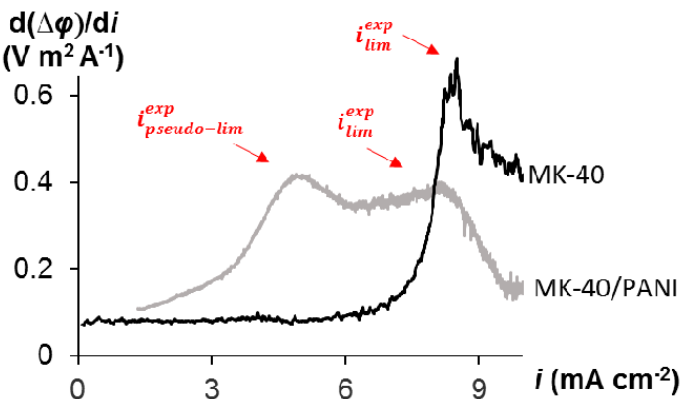
Figure 3. Derived I-V curves, d( ∆ ϕ ) / d i , for MK-40 and MK-40 / PANI membranes in the model solution at the corresponding current density.